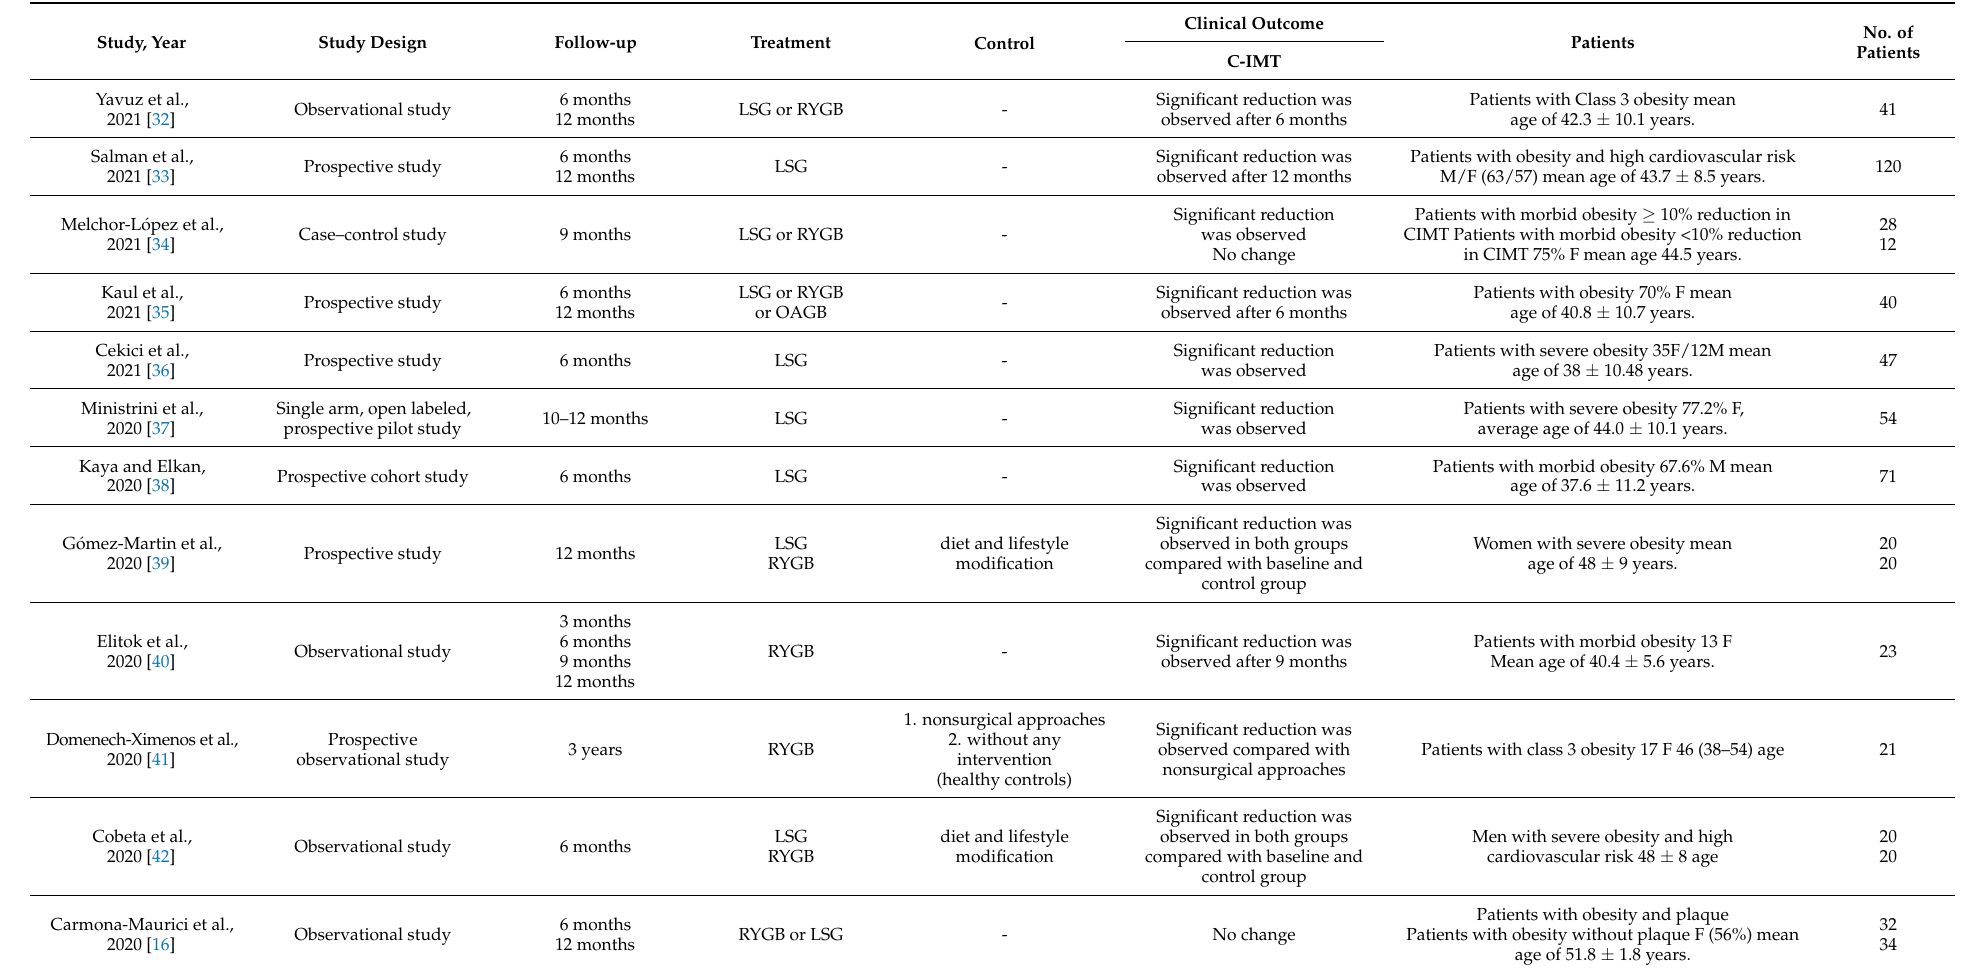
Table 1. Characteristics of studies measuring